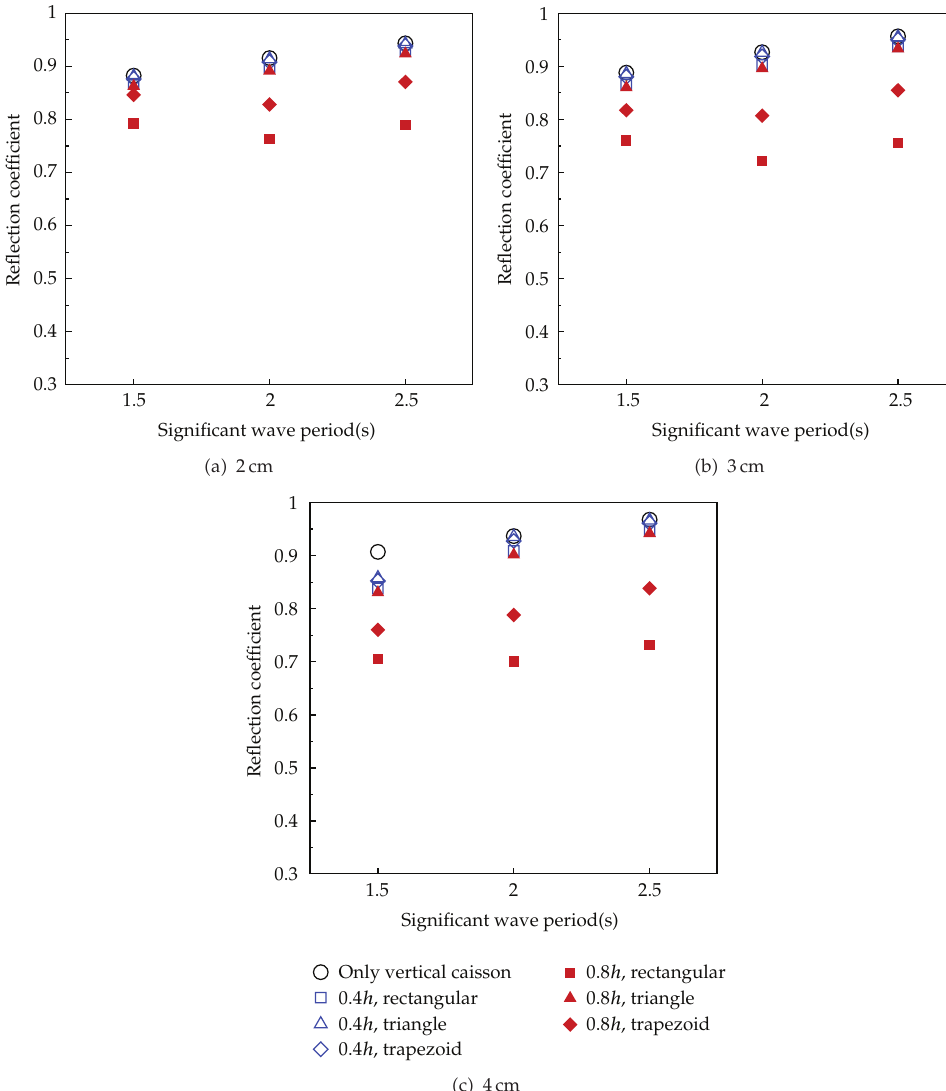
Figure 5: Reflection coe ffi cient for vertical caisson with di ff erent significant wave